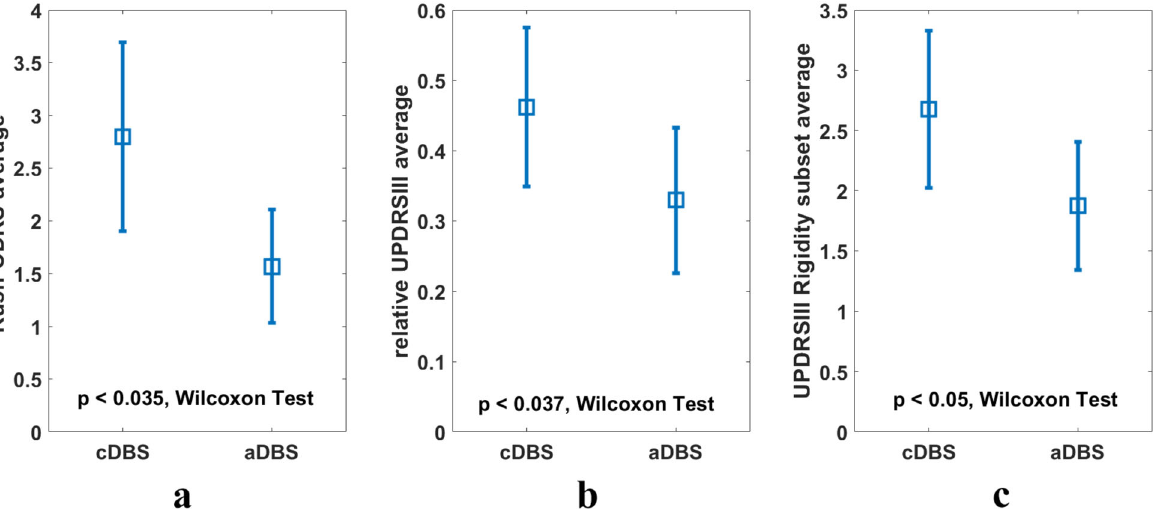
Fig. 1 Clinical scores of the cDBS and aDBS groups. Histograms represents average and standard deviation of ( a ) Rush-DRS average, ( b ) relative UPDRS-III average, ( c ) UPDRS-III rigidity subset